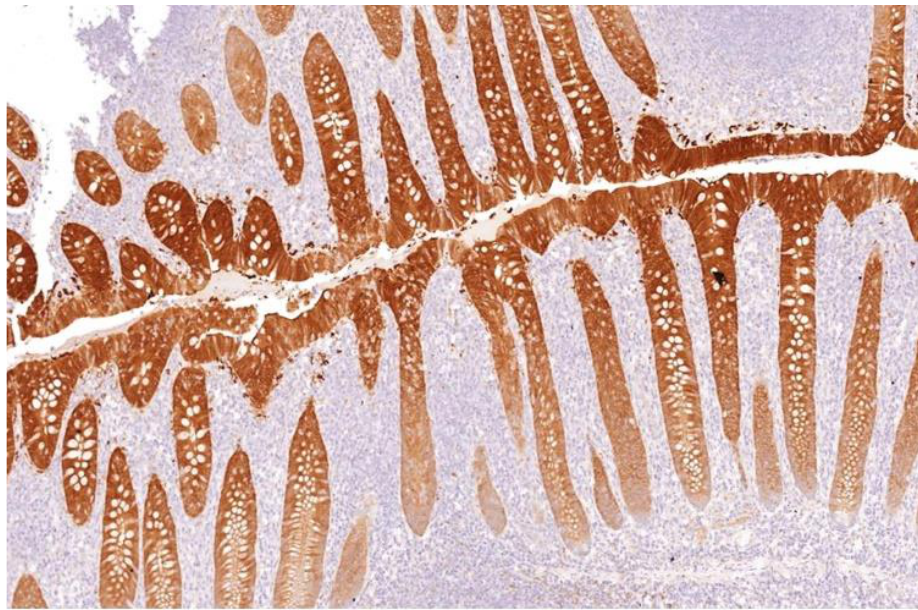
Figure 1. Galectin-3 staining strongly as brown stain after IHC in appendix crypts of Lierberkuhn (control) (×100). (control) ( ×